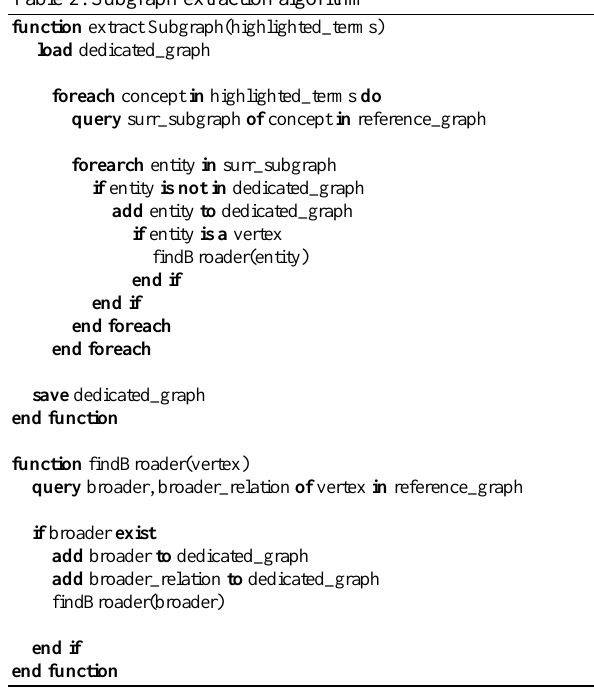
Table 2. Subgraph extraction algorithm